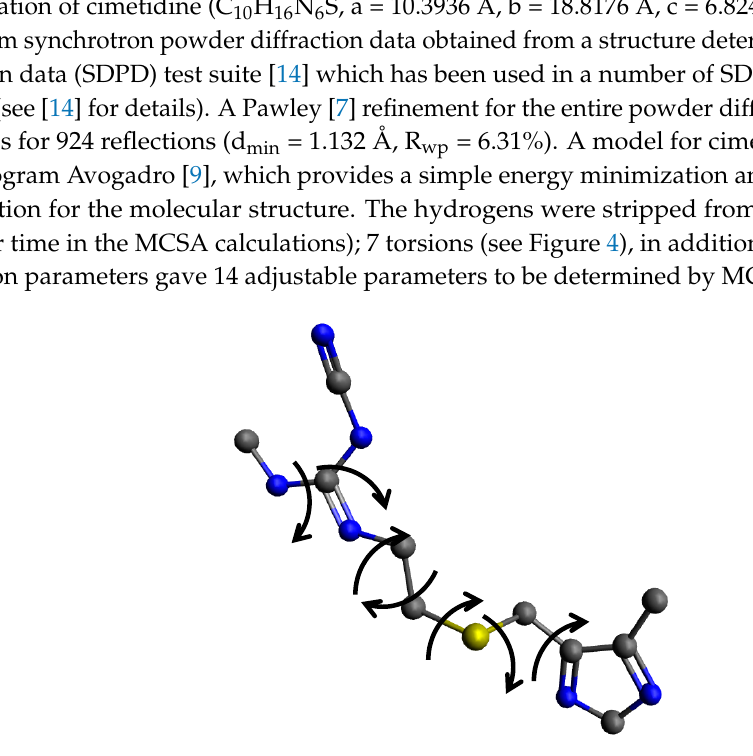
Figure 4. The molecular model for cimetidine; hydrogen atoms are not shown. The seven variable torsion angles are indicated. C atoms are shown in gray, N in blue, and S in yellow.